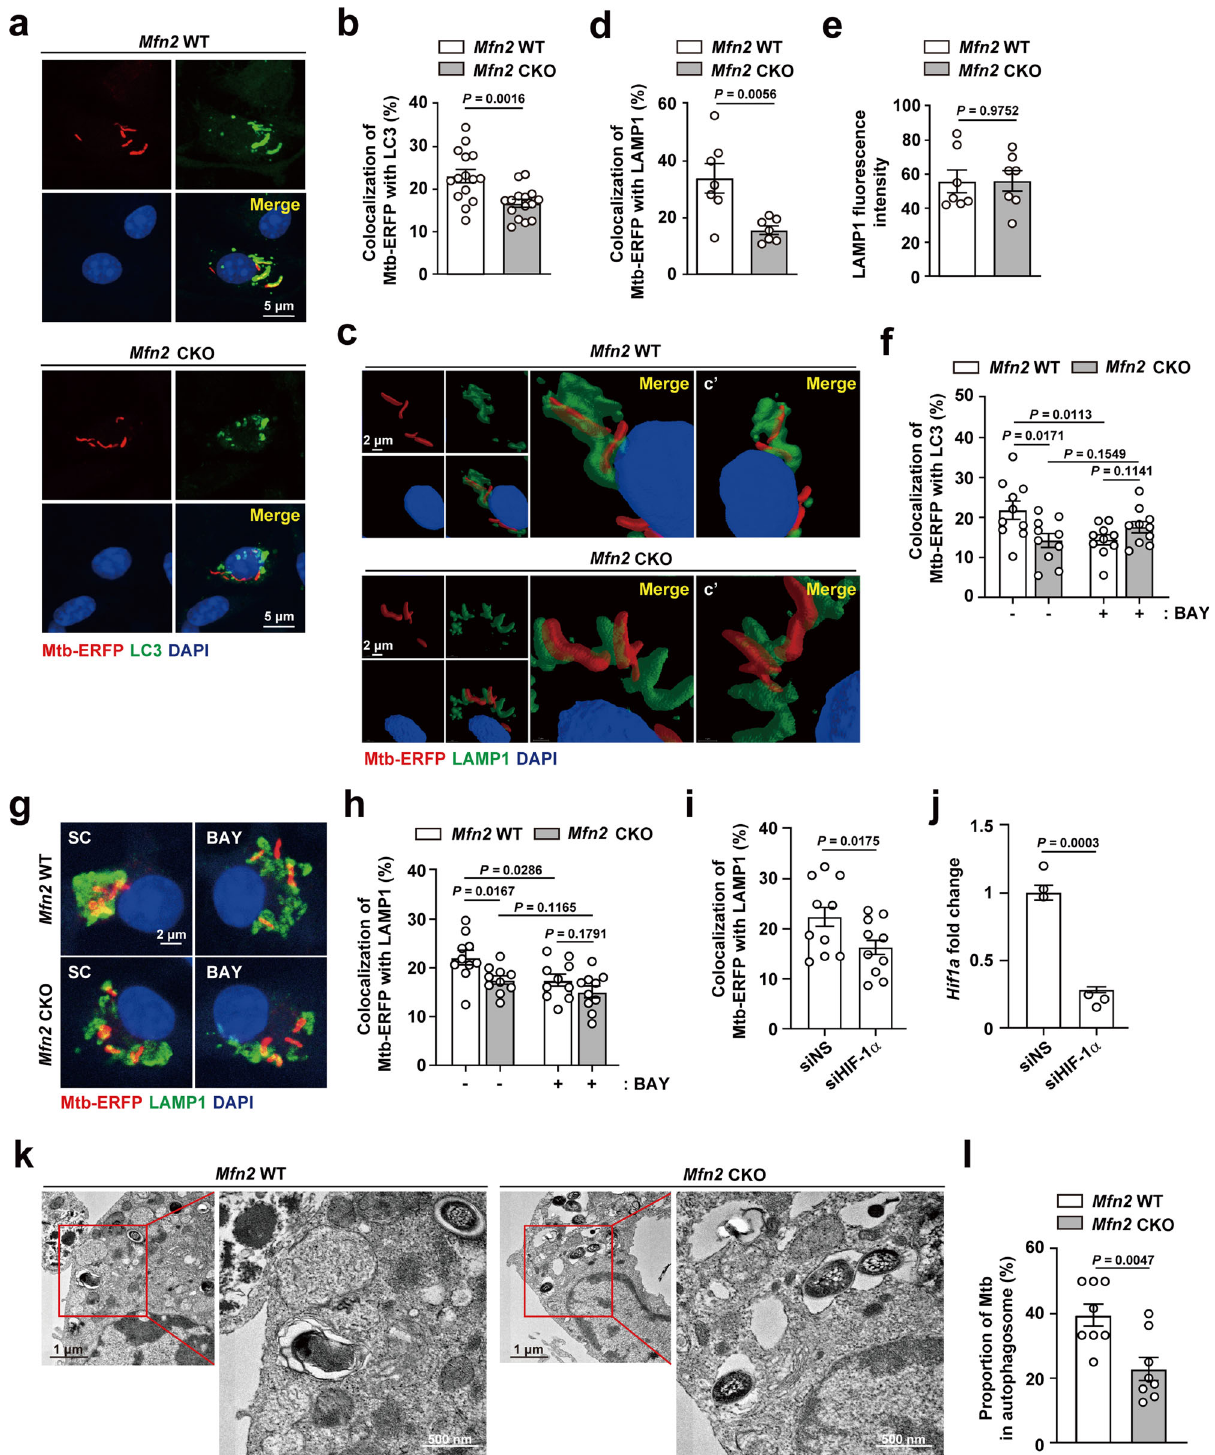
phagosomes, autophagosomes, and lysosomes to assess whether co-localization ef fi ciency depends on MFN2 expression in mac- rophages. We observed that co-localization between Mtb phago- somes and LC3 autophagosomes was signi fi cantly downregulated in Mfn2 CKO BMDMs, compared with those in Mfn2 WT BMDMs (Fig. 7a, b). In addition, MFN2 de fi ciency led to a sig- ni fi cant decrease in the level of co-localization between Mtb phagosomes and lysosomes after infection (Fig. 7c, d). Further- more, we measured the autophagy fl ux by using a retroviral vector